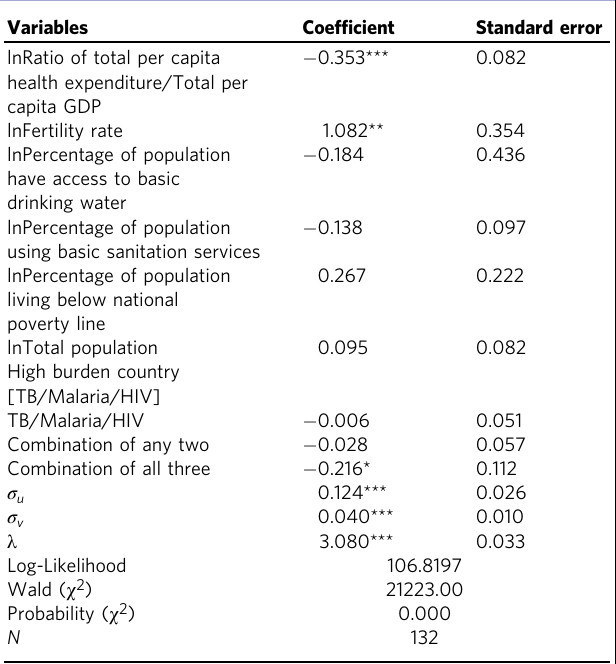
Table 3 MLE estimation of SFA || Dependent variable: lnU5 mortality